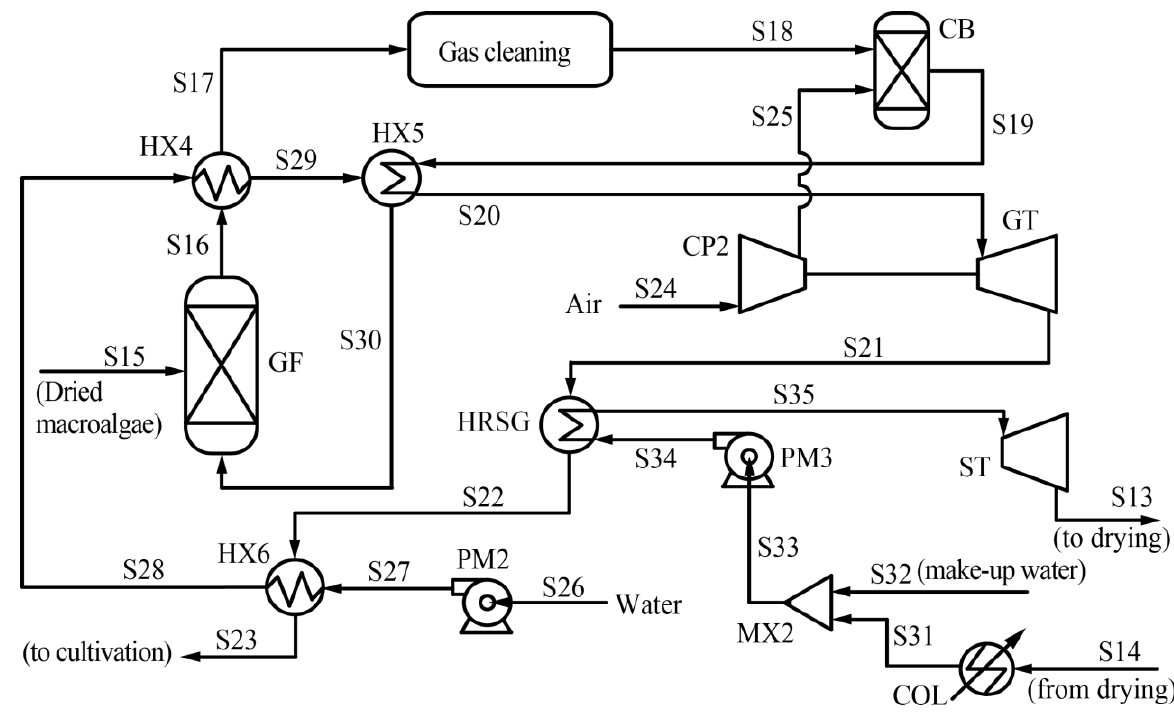
Figure 4. Process flow diagram of gasification and combined cycle modules in the proposed